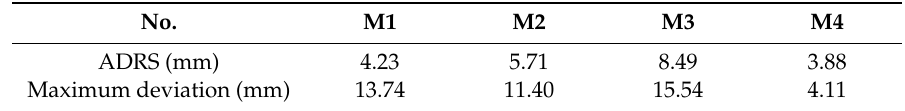
Table 5. The average deviation from the reference surface (ADRS) and the maximum deviation of each mirror in the initial structure.